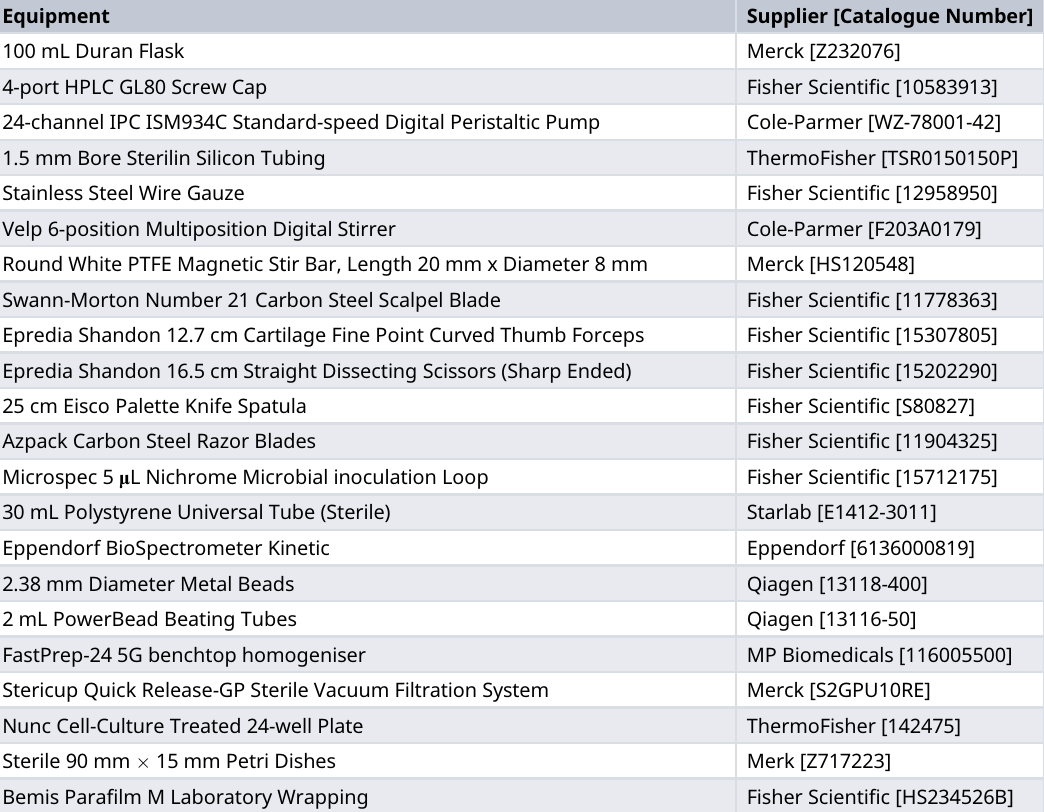
Table 3. Equipment used in this